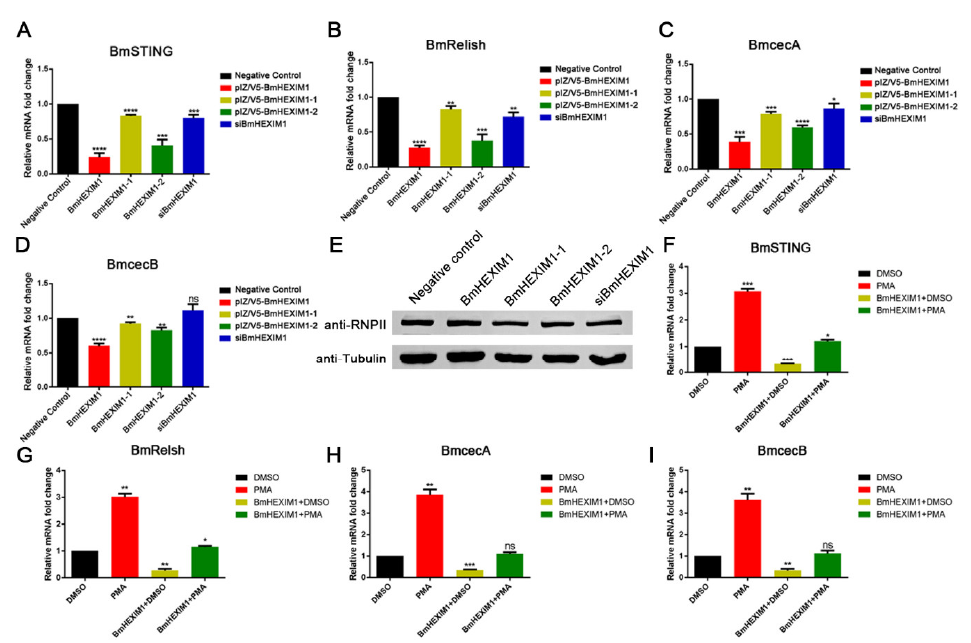
Figure 4. BmHEXIM1 suppresses host innate immunity during BmNPV infection. ( A – D ) Quantifica- tion of the expression of BmSTING, BmRelish, BmcecA, and BmcecB by qRT-PCR after overexpression of BmHEXIM1, BmHEXIM1-1, BmHEXIM1-2, or knockdown of BmHEXIM1 in BmN cells after Bm- NPV infection. ( E ) The phosphorylation level of RNP II by Western blot after overexpression of BmHEXIM1, BmHEXIM1-1, BmHEXIM1-2, or knockdown of BmHEXIM1 in BmN cells. ( F – I ) In the absence or presence of PMA, the expression of BmSTING, BmRelish, BmcecA, and BmcecB was also analyzed by qRT-PCR or by the co-expression of HEXIM1. The mRNA level of target genes was normalized to the internal control (BmRPL32). Data represent mean ± SEM of the three independent experiments. The number of asterisks represents the degree of significance with respect to p